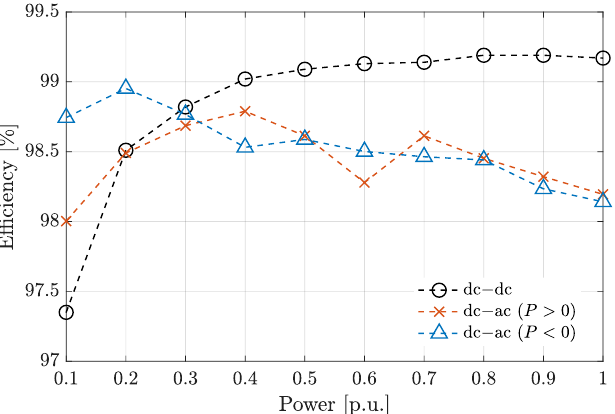
Figure 7. Power efficiency of the PCS components: Inverters and dc–dc converters. The efficiencies are functions of the normalized rating power.